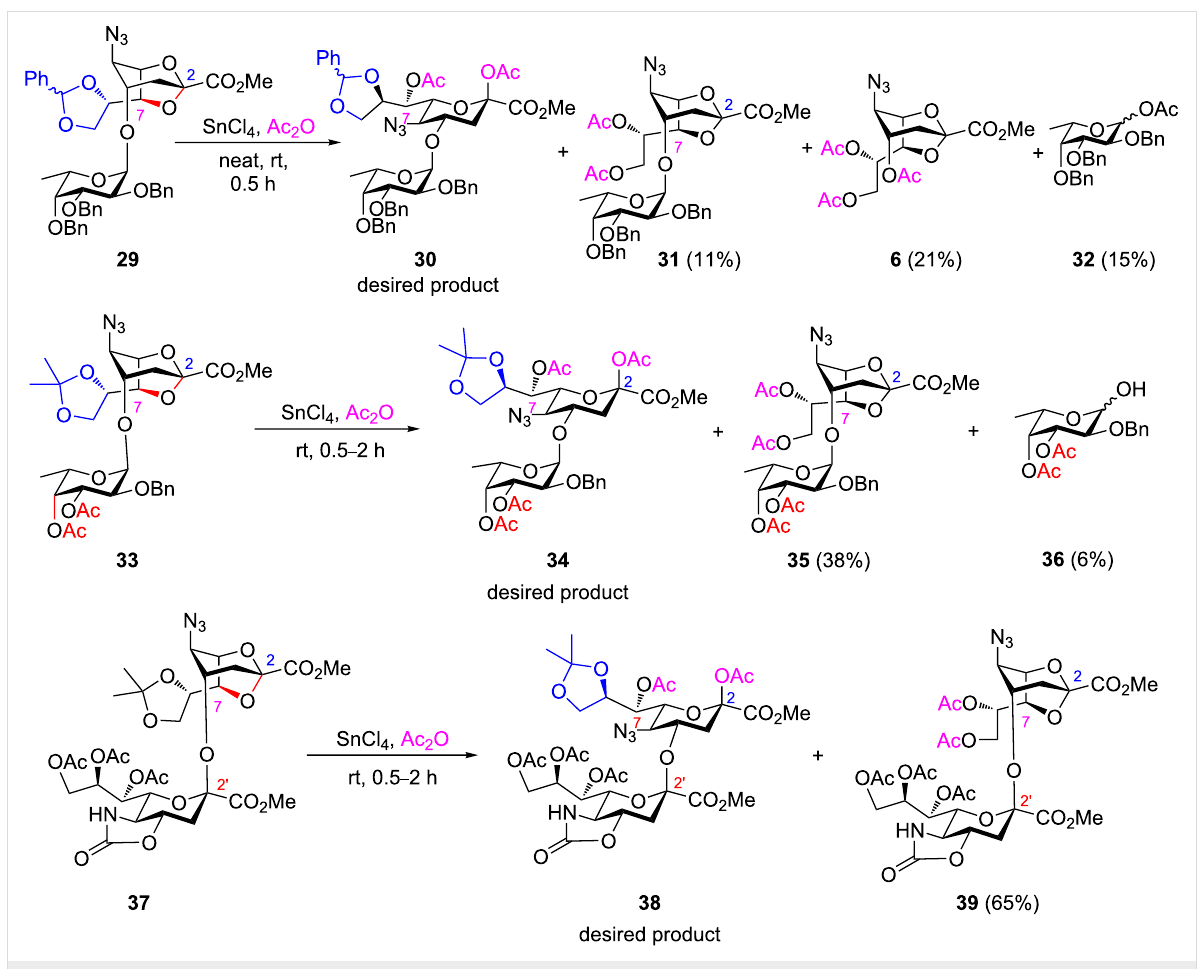
Scheme 5: Attempted acetolysis of 2,7-anhydro-NeuN 3 -based disaccharides 29 , 33 , and 37 .